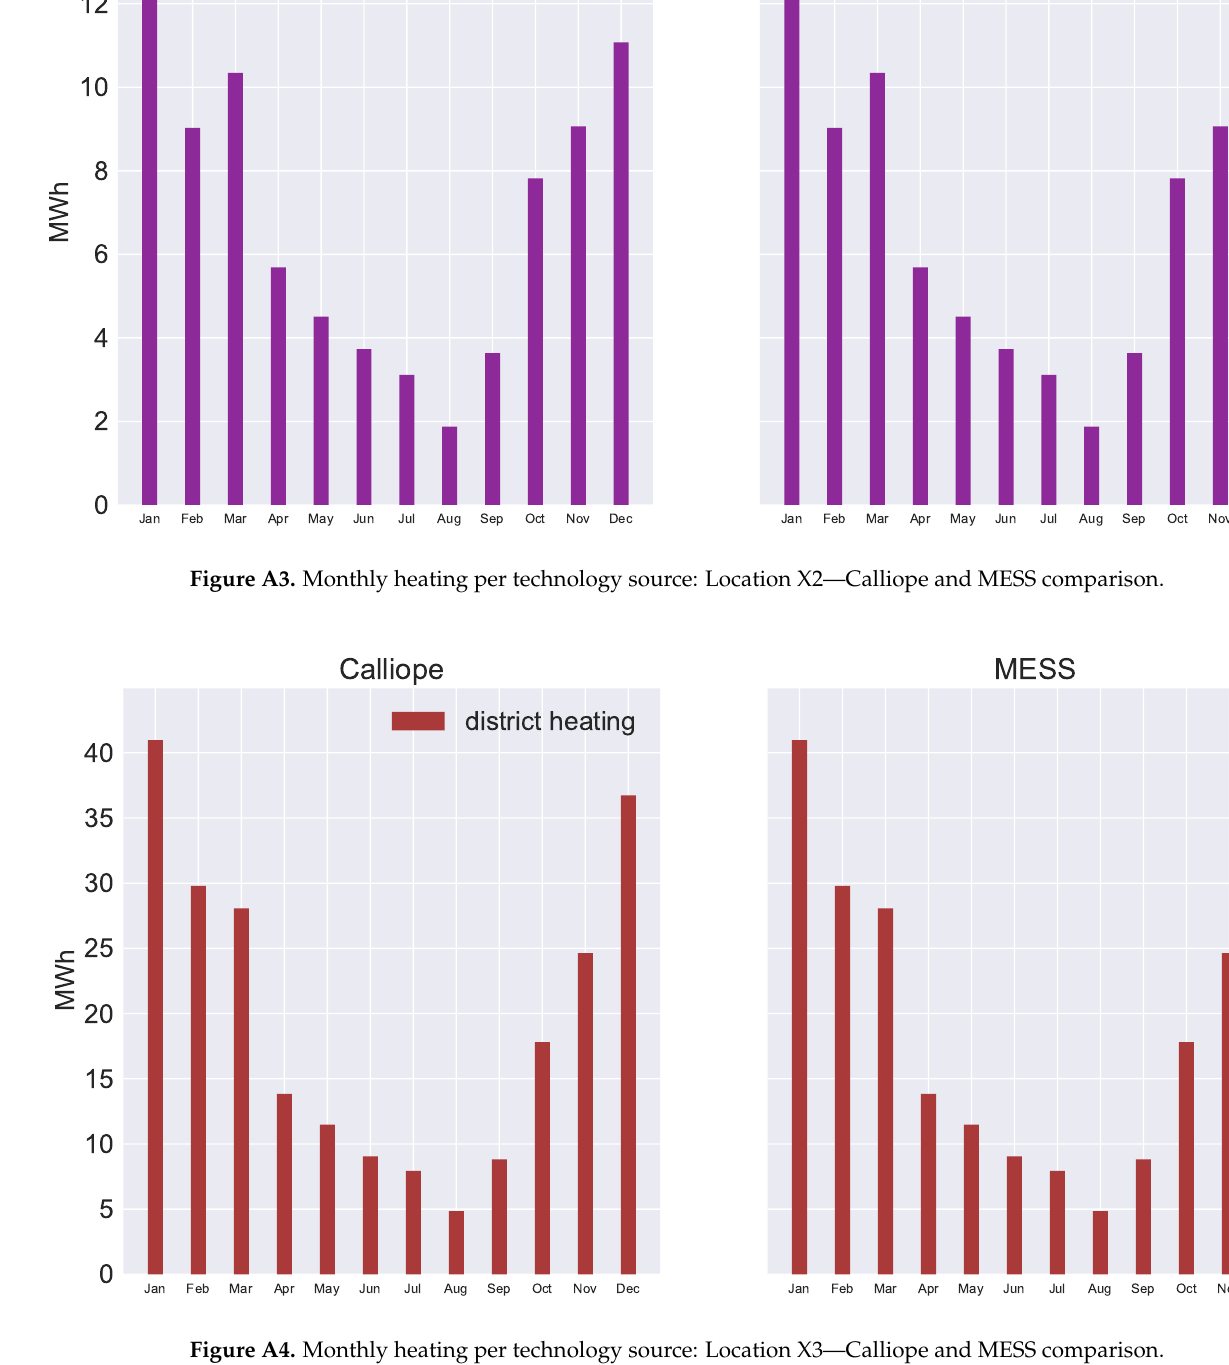
Figure A4. Monthly heating per technology source: Location X3—Calliope and MESS